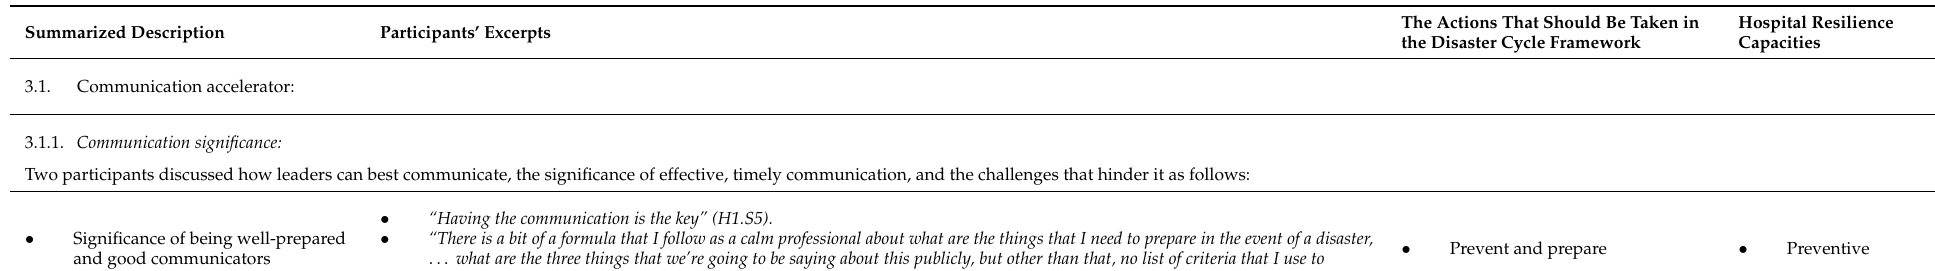
Table 4. Communication and